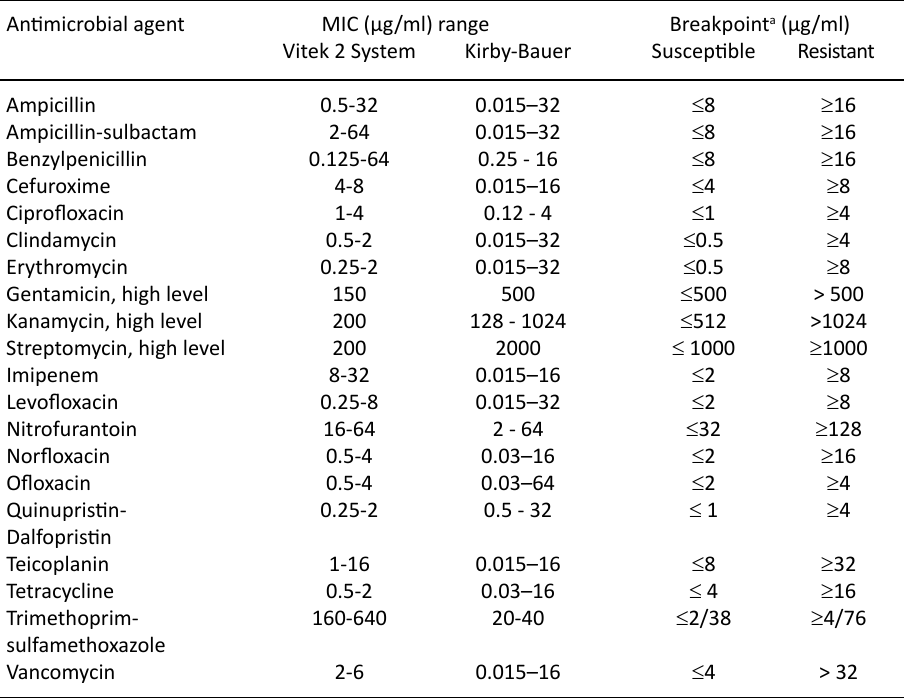
Table 1. Concentration range (µg/ml) of antimicrobial agents and breakpoints used in antibiotic susceptibility test Antimicrobial